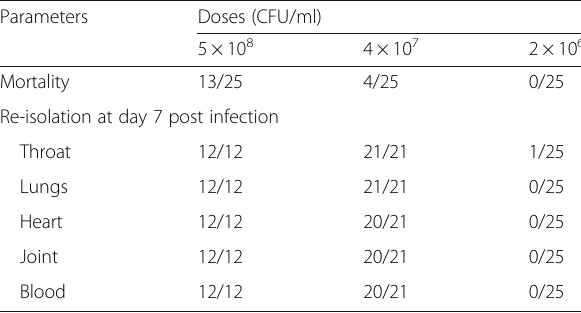
Table 1 Pilot study: Effects of different doses of S. aureus (KY698020) on survival and re-isolation frequency in mice Parameters